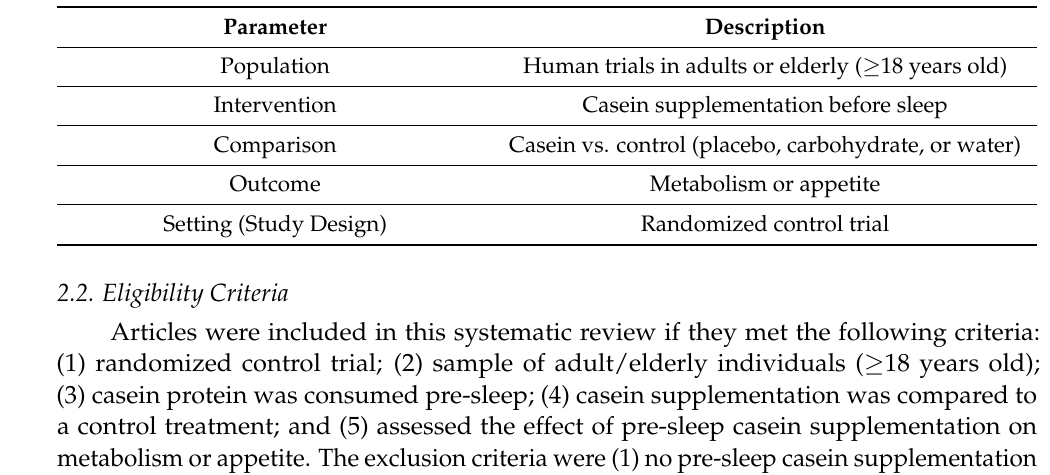
Table 1. PICOS (Population, Intervention, Comparison, Outcome, Setting) criteria for inclusion of